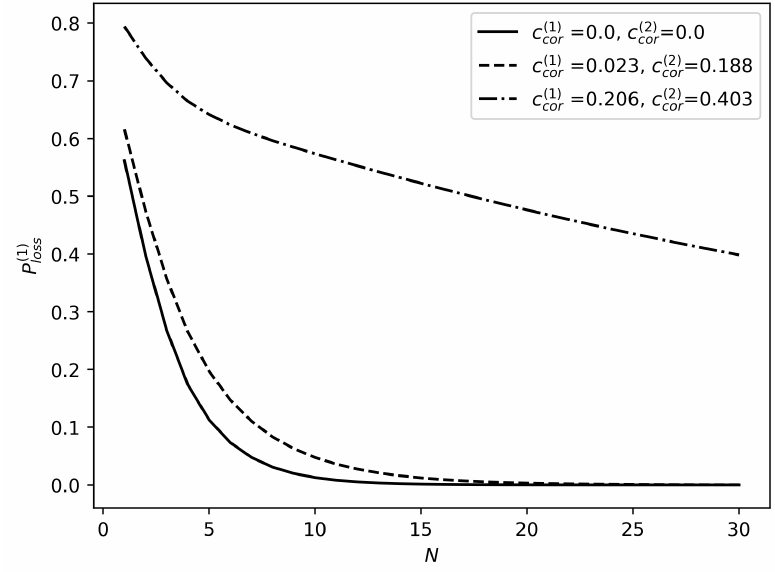
( 1 ) as a function of the buffer capacity N for BMMAP s with different loss